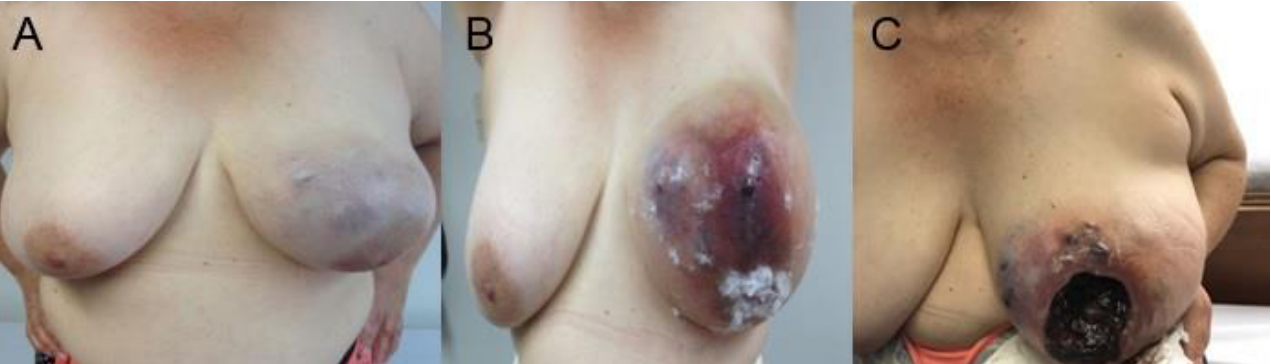
Figure 2. ( A ) An irregular lobulated lesion can be observed that involves 70% of the left breast. ( B ) Progression of the lesion involving the skin and the nipple-areola complex. ( C ) In this tumor type, involvement consists of ulceration and necrosis of the mammary